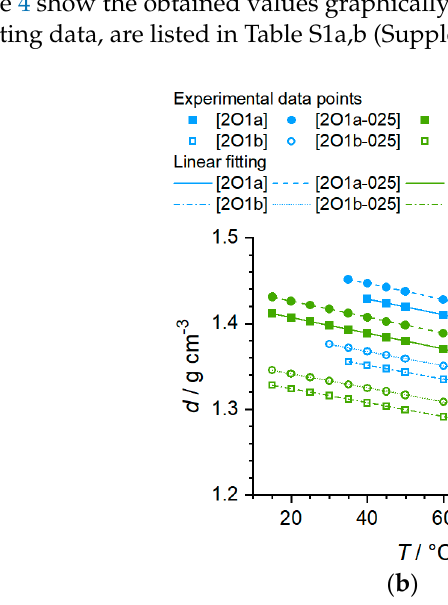
Figure 4. Density data of the ILs and IL–salt mixtures. ( a ) n ‐ Alkyl phosphonium ionic liquids and salt mixtures; ( b ) Ether ‐ containing phosphonium ionic liquids and IL salt mixtures.